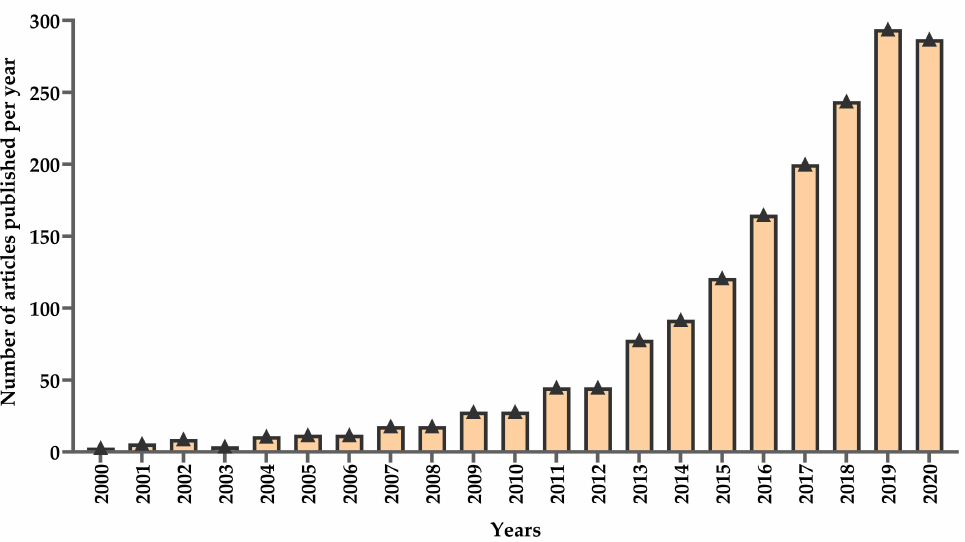
Figure 2. The number of high-intensity interval-training articles published in